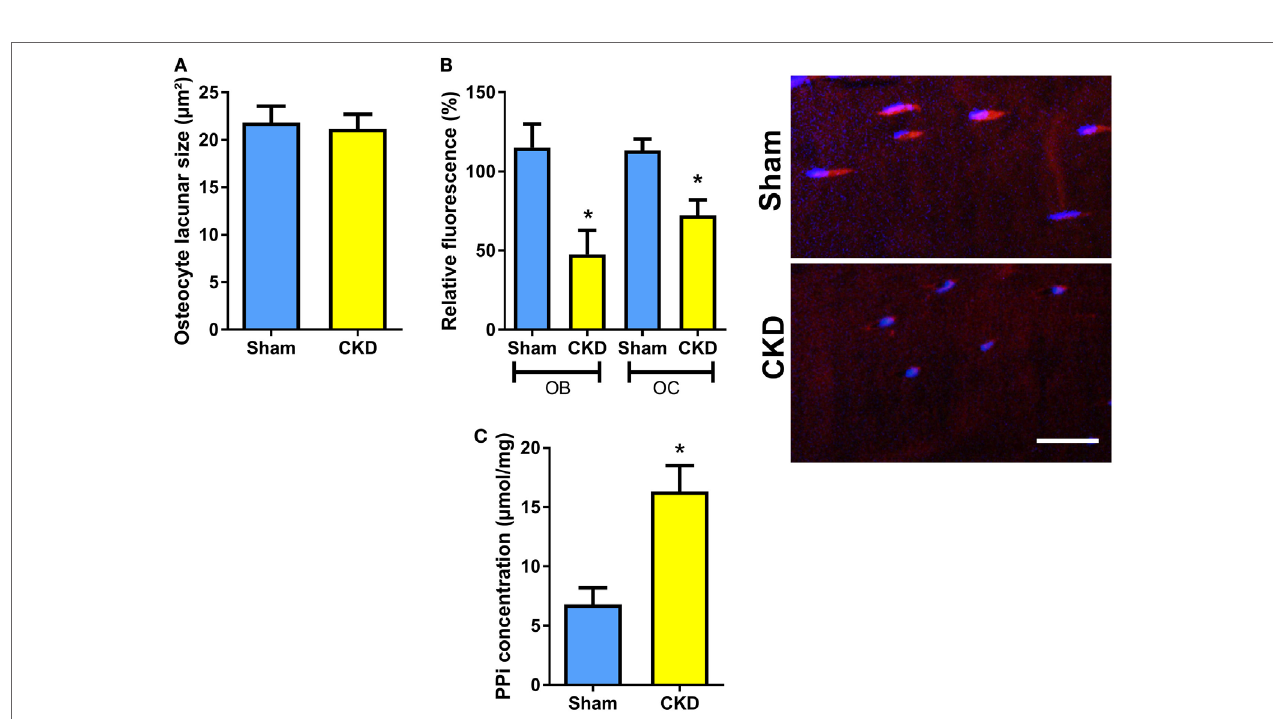
FigUre 4 | Decreased tissue nonspecific alkaline phosphatase (TNAP) enzyme activity and increased pyrophosphate concentrations in bones of chronic kidney disease (CKD) mice. (a) Mean area of osteocyte lacunae measured by histomorphometry in tibial cortical bone ( n = 13–14 each), (B) quantification of relative fluorescence after histochemical TNAP staining of osteoblasts (OB) and osteocytes (OC) in undecalcified sections of proximal tibiae ( n = 3 each) and representative images of cortical bone osteocytes in Sham and CKD mice, and (c) pyrophosphate (PPi) concentration in extracts of femurs ( n = 3–5 each) from 5-month-old male C57BL/6 Sham and CKD mice on rescue diet, 8 weeks postsurgery. Data in (a–c) are mean ± SEM. In (B) , * denotes P < 0.05 vs. Sham by one-way analysis of variance followed by Holm–Sidak’s multiple comparisons test. In (c) , * denotes P < 0.05 vs. Sham by t -test. Bar = 20 µm in (B)